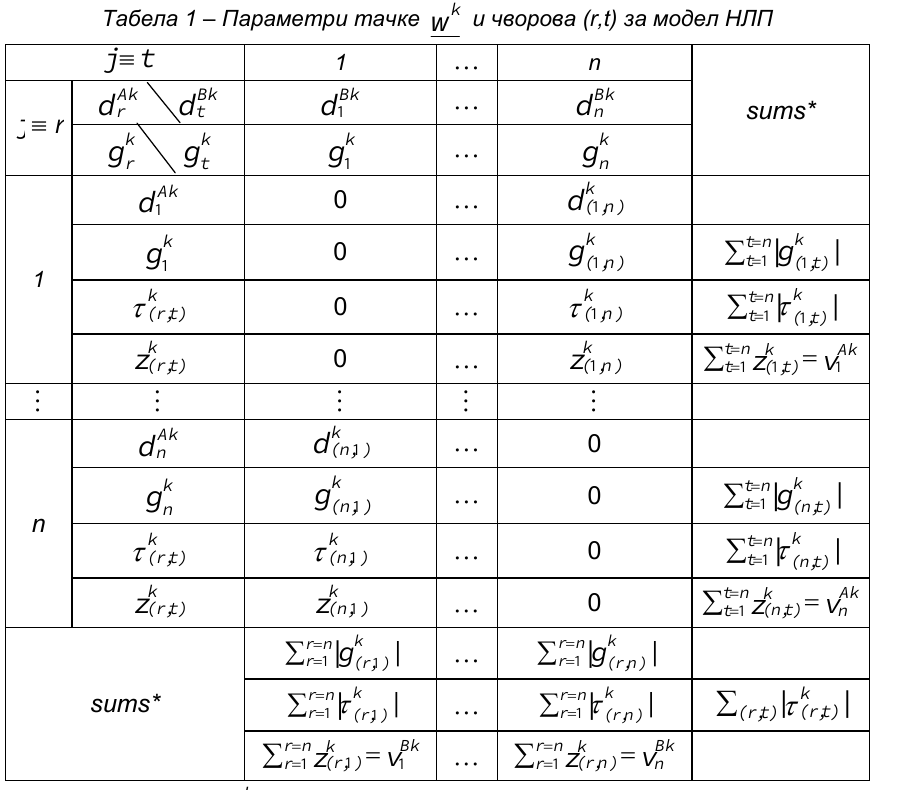
Table 1 – Parameters of the point w k and the nodes (r, t) for the NLP model Таблица 1 – Параметры точки w k и узлов (r, t) для модели